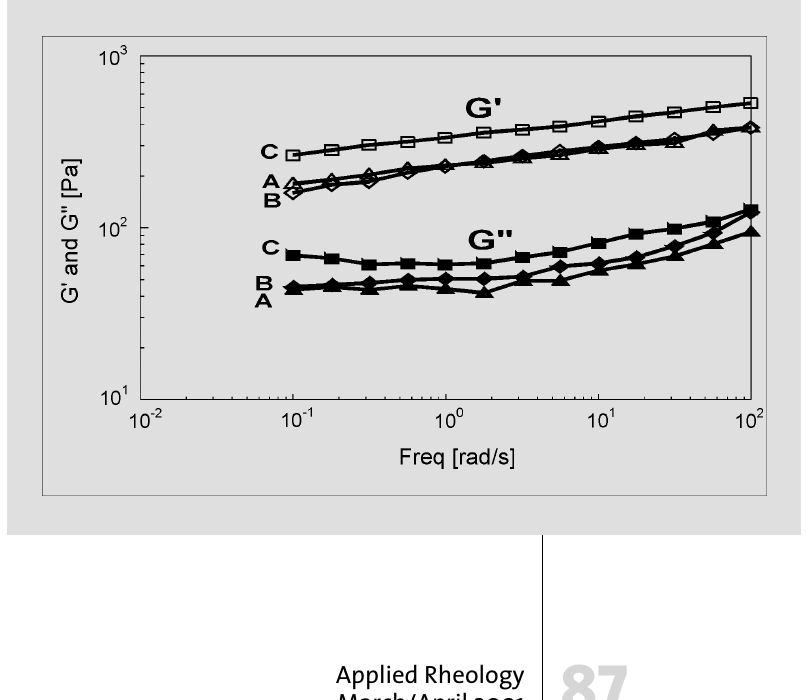
Figure 11: Frequency depen- dence data at